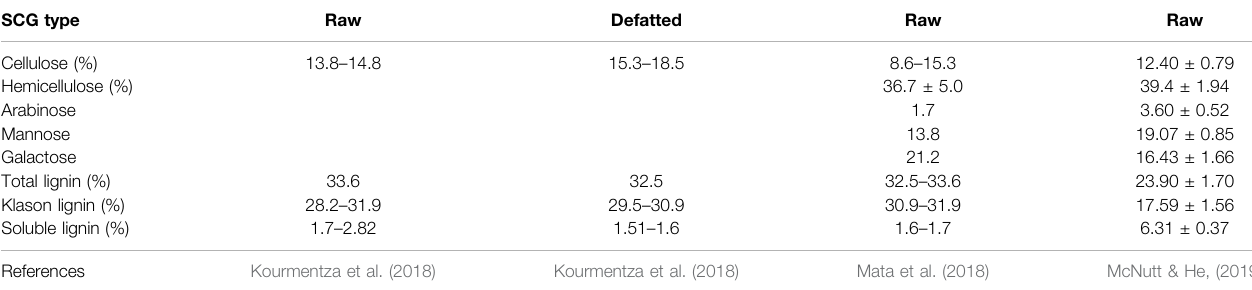
TABLE 2 | Cellulose and lignin contents of SCGs.